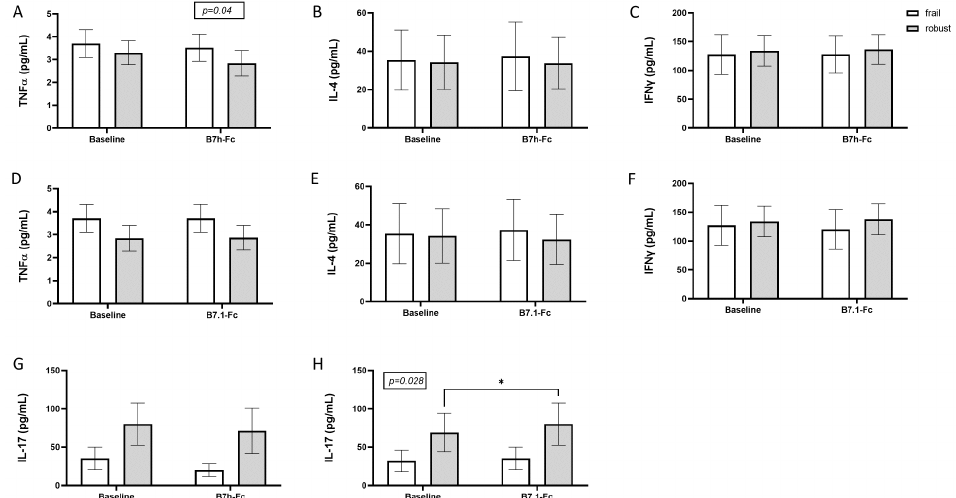
Figure 2. In vitro cytokine production in PBMCs from frail and robust older subjects after immune Figure 2 . In vitro cytokine production in PBMCs from frail and robust older subjects after immune Figure 2 . In vitro cytokine production in PBMCs from frail and robust older subjects after immune stimulation. Panel ( A ) TNF α in frail and robust subjects at baseline and after stimulation with stimulation. Panel ( A ) TNFα in frail and robust subjects at baseline and after stimulation with B7h- stimulation. Panel ( A ) TNFα in frail and robust subjects at baseline and after stimulation with B7h- B7h-Fc. Panel ( B ) IL-4 in frail and robust subjects at baseline and after stimulation with B7h-Fc. Fc. Panel ( B ) IL-4 in frail and robust subjects at baseline and after stimulation with B7h-Fc. Panel ( C ) Figure 2 . In vitro cytokine production in PBMCs from frail and robust older subjects after immune Fc. Panel ( B ) IL-4 in frail and robust subjects at baseline and after stimulation with B7h-Fc. Panel ( C ) IFN ϒ cells in frail and robust subjects at baseline and after stimulation with B7h-Fc. Panel ( D ) TNFα Panel ( C ) IFN cells in frail and robust subjects at baseline and after stimulation with B7h-Fc. Panel stimulation. Panel ( A ) TNFα in frail and robust subjects at baseline and after stimulation with B7h- IFN cells in frail and robust subjects at baseline and after stimulation with B7h-Fc. Panel ( D ) TNFα in frail and robust subjects at baseline and after stimulation with B7.1-Fc. Panel ( E ) IL-4 in frail and ( D ) TNF α in frail and robust subjects at baseline and after stimulation with B7.1-Fc. Panel ( E ) IL-4 in Fc. Panel ( B ) IL-4 in frail and robust subjects at baseline and after stimulation with B7h-Fc. Panel ( C ) in frail and robust subjects at baseline and after stimulation with B7.1-Fc. Panel ( E ) IL-4 in frail and robust subjects at baseline and after stimulation with B7.1-Fc. Panel ( F ) IFN ϒ in frail and robust IFN ϒ cells in frail and robust subjects at baseline and after stimulation with B7h-Fc. Panel ( D ) TNFα frail and robust subjects at baseline and after stimulation with B7.1-Fc. Panel ( F ) IFN in frail and ϒ robust subjects at baseline and after stimulation with B7.1-Fc. Panel ( F ) IFN in frail and robust subjects at baseline and after stimulation with B7.1-Fc. Panel ( G ) IL-17 in frail and robust subjects at in frail and robust subjects at baseline and after stimulation with B7.1-Fc. Panel ( E ) IL-4 in frail and robust subjects at baseline and after stimulation with B7.1-Fc. Panel ( G ) IL-17 in frail and robust subjects at baseline and after stimulation with B7.1-Fc. Panel ( G ) IL-17 in frail and robust subjects at baseline and after stimulation with B7h-Fc. Panel ( H ) IL-17 in frail and robust subjects at baseline robust subjects at baseline and after stimulation with B7.1-Fc. Panel ( F ) IFN ϒ in frail and robust ϒ subjects at baseline and after stimulation with B7h-Fc. Panel ( H ) IL-17 in frail and robust subjects baseline and after stimulation with B7h-Fc. Panel ( H ) IL-17 in frail and robust subjects at baseline and after stimulation with B7.1-Fc. The graphs show means and standard deviations; data were subjects at baseline and after stimulation with B7.1-Fc. Panel ( G ) IL-17 in frail and robust subjects at and after stimulation with B7.1-Fc. The graphs show means and standard deviations; data were analyzed by two-way ANOVA for repeated measures; multiple comparisons were performed by baseline and after stimulation with B7h-Fc. Panel ( H ) IL-17 in frail and robust subjects at baseline analyzed by two-way ANOVA for repeated measures; multiple comparisons were performed by means of Šídák ’ s multiple comparisons test. Significant p -values are shown; p -values reported in and after stimulation with B7.1-Fc. The graphs show means and standard deviations; data were means of Šídák ’ s multiple comparisons test. Significant p -values between baseline and after stimuli squares are values obtained by two-way ANOVA tests. Significant p -values between baseline and analyzed by two-way ANOVA for repeated measures; multiple comparisons were performed by are indicated as asterisk (*); p -values reported in squares are values obtained by two-way ANOVA after stimuli are indicated as asterisk (*) means of Šídák ’ s multiple comparisons test. Significant p -values are shown; p -values reported in tests. squares are values obtained by two-way ANOVA tests. Significant p -values between baseline and